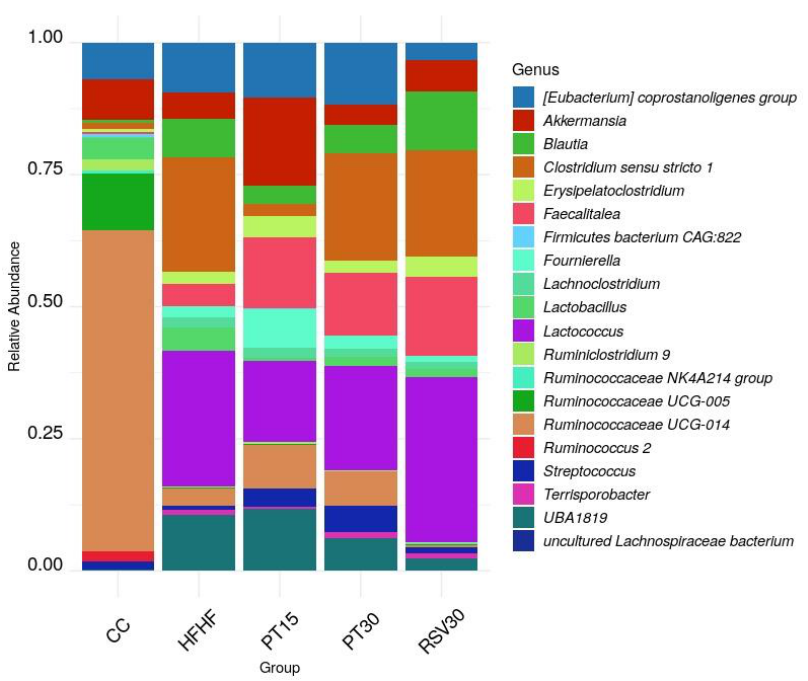
Figure 5. Histogram representing the twenty most abundant genera.